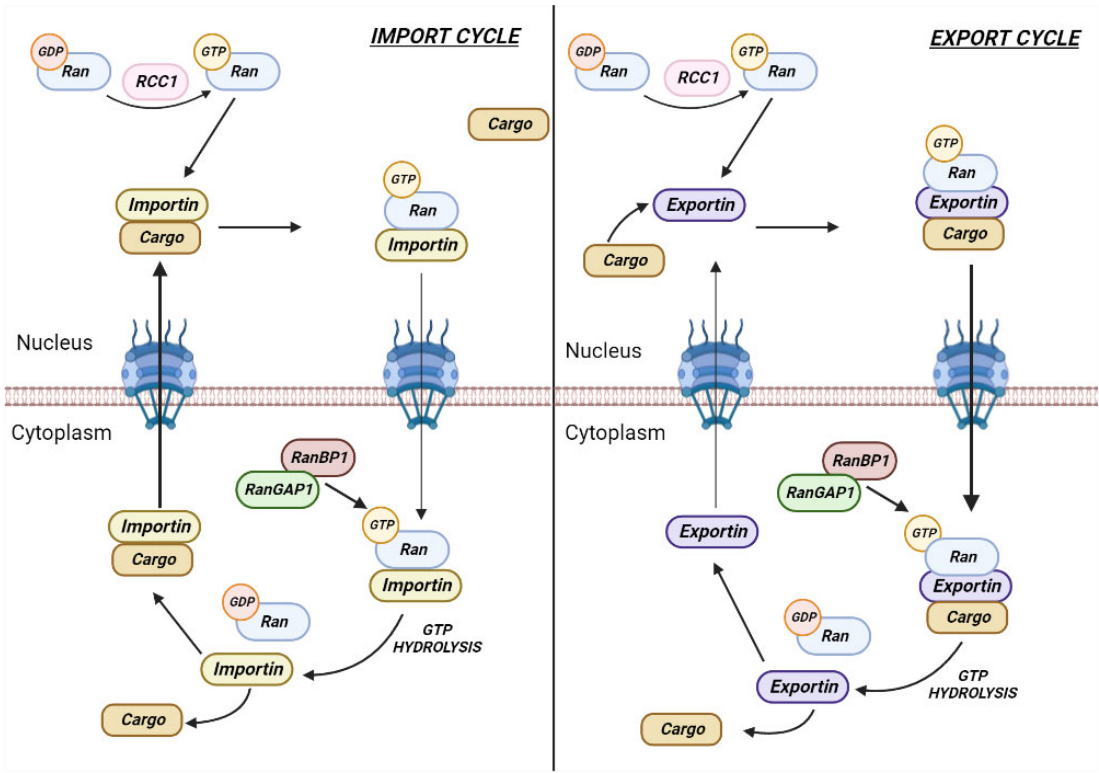
Figure 2. RANBP1 mediates nuclear transport through the RAN complex (arbitrary putative model). Nucleus import and export cycles and model for Importins/Exportins (carrier proteins) recycling. Importins ( left ) bind to cargo in the cytoplasmic side and allow interactions with the nuclear pore complex to promote translocation of the import complex into the nucleus. RanGTP in the nucleus binds to importin and favors cargo release. The importin ‐ RanGTP complex is then recycled into the cytoplasm, where RanGTP is detached from importin through RanBP1 ‐ RanGAP1 dependent GTP hydrolysis. The export cycle is comparable ( right ) but RanGTP induces cargo binding in the nucleus. After removal of RanGTP from the complex through RANBP1/RANGAP1 ‐ dependent hydrolysis of GTP in the cytoplasm, exportins separates from cargo and the empty receptor is recycled into the nucleus. Freely inspired and adapted from [26]